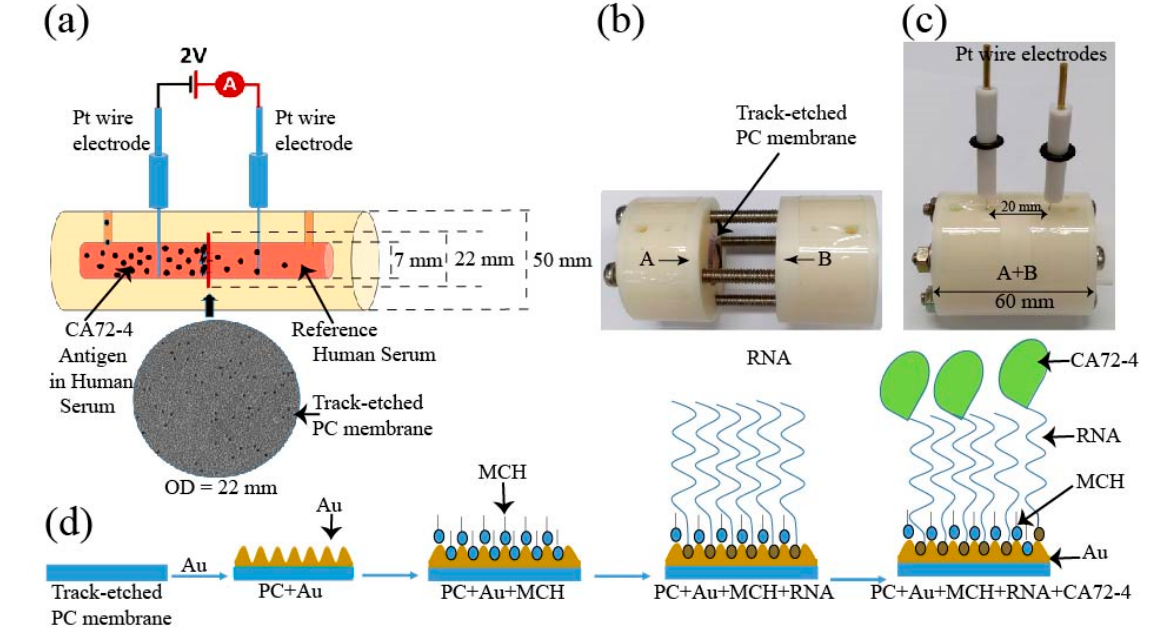
Figure 1. Schematic diagram of the design of the electrochemical sensor for detection of the CA72-4 cancer antigen. ( a ) Design of track-etched membrane-based electrochemical sensor. ( b ) The electrochemical cells before integration. ( c ) Integrated Teflon electrochemical cells with platinum (Pt) reference electrodes. ( d ) Surface modification of polycarbonate (PC) membranes and detection of cancer antigen CA72-4.